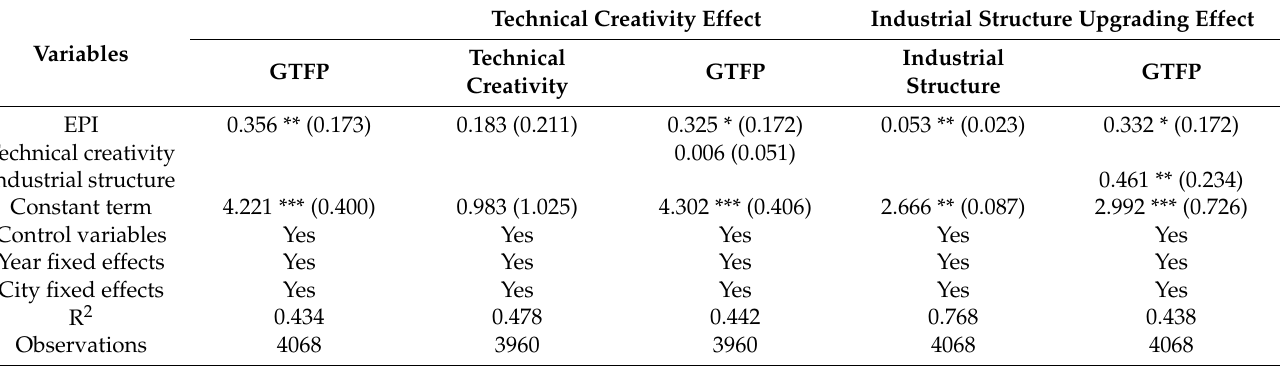
Table 6. Eliminating the interference of other policies and winsorzing extreme values.